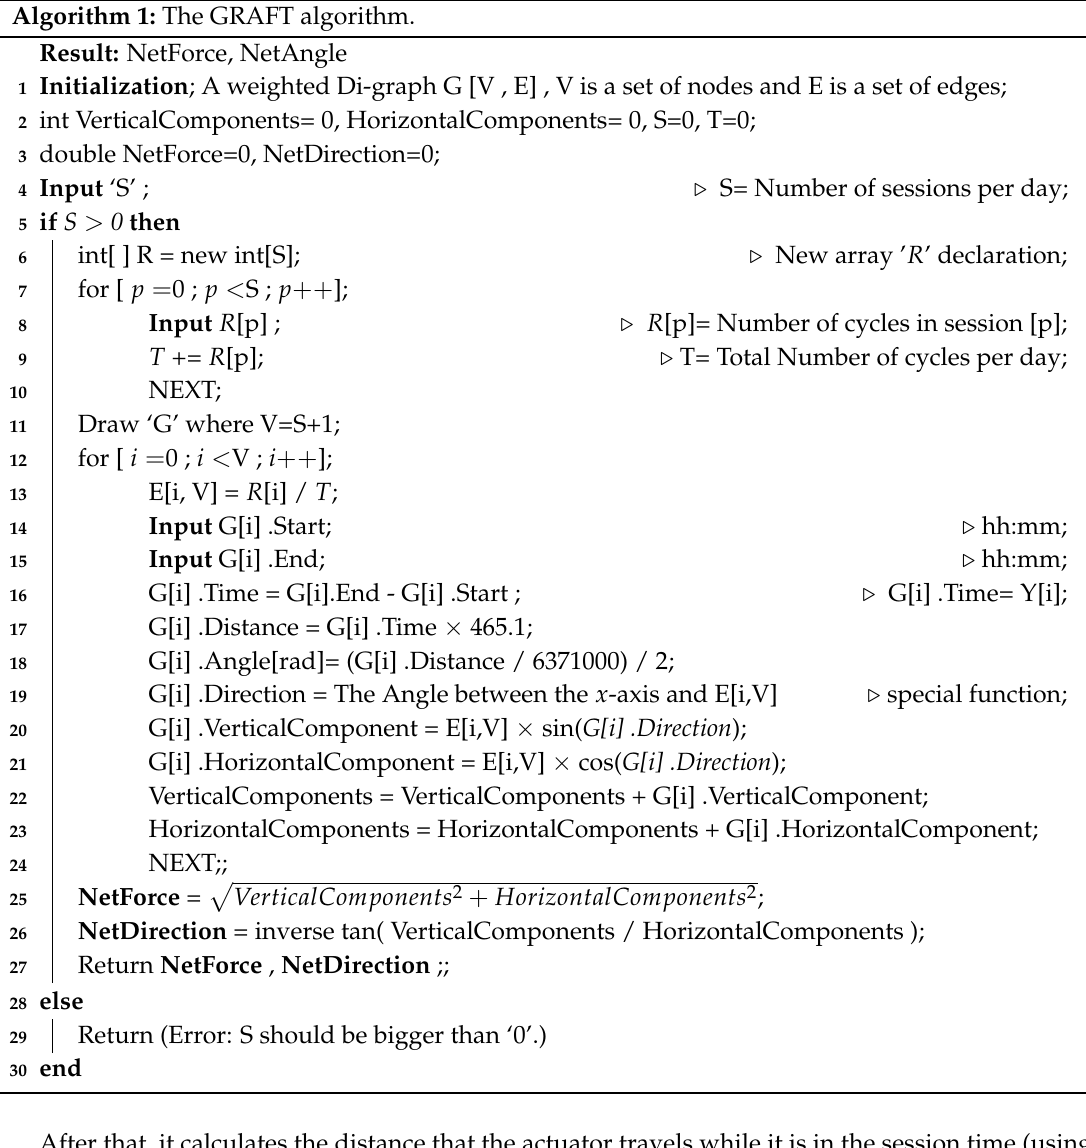
Algorithm 1: The GRAFT